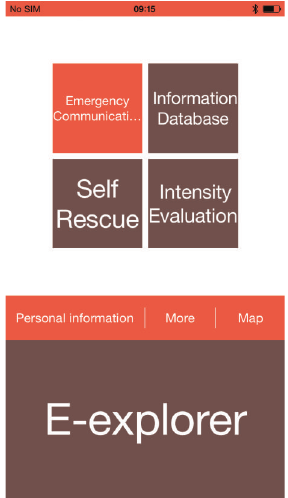
Figure 1: Main interface of E-Explorer.